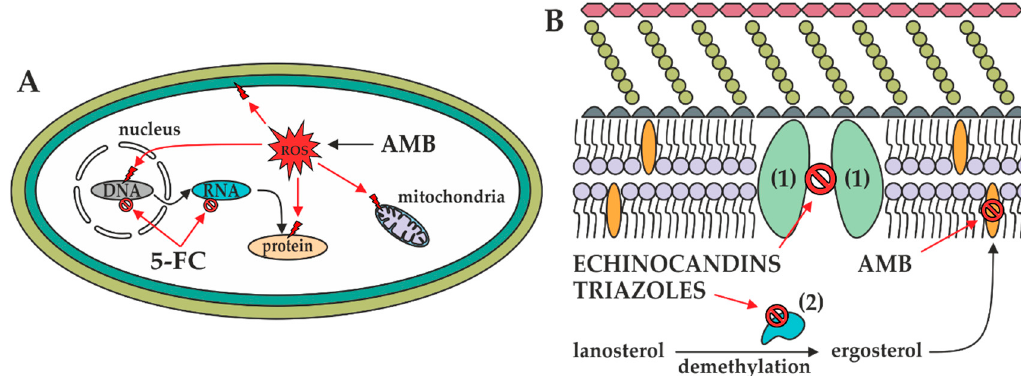
Figure 3. Mechanisms of actions of antifungals in the fungal cell. ( A ): In the fungal cytoplasm, AMB induces ROS formation resulting in the mitochondrial, biomembrane, DNA, and protein damage. Furthermore, 5-FC prevents DNA, RNA, and thus protein biosynthesis. ( B ): In the fungal biomembrane, 1,3- β - D -glucan synthase (1) and 14- α -demethylase (2) are inhibited by echinocandins and triazoles, respectively. Additionally, ergosterol contained in the biomembrane is sequestered by AMB, resulting in pore formation.